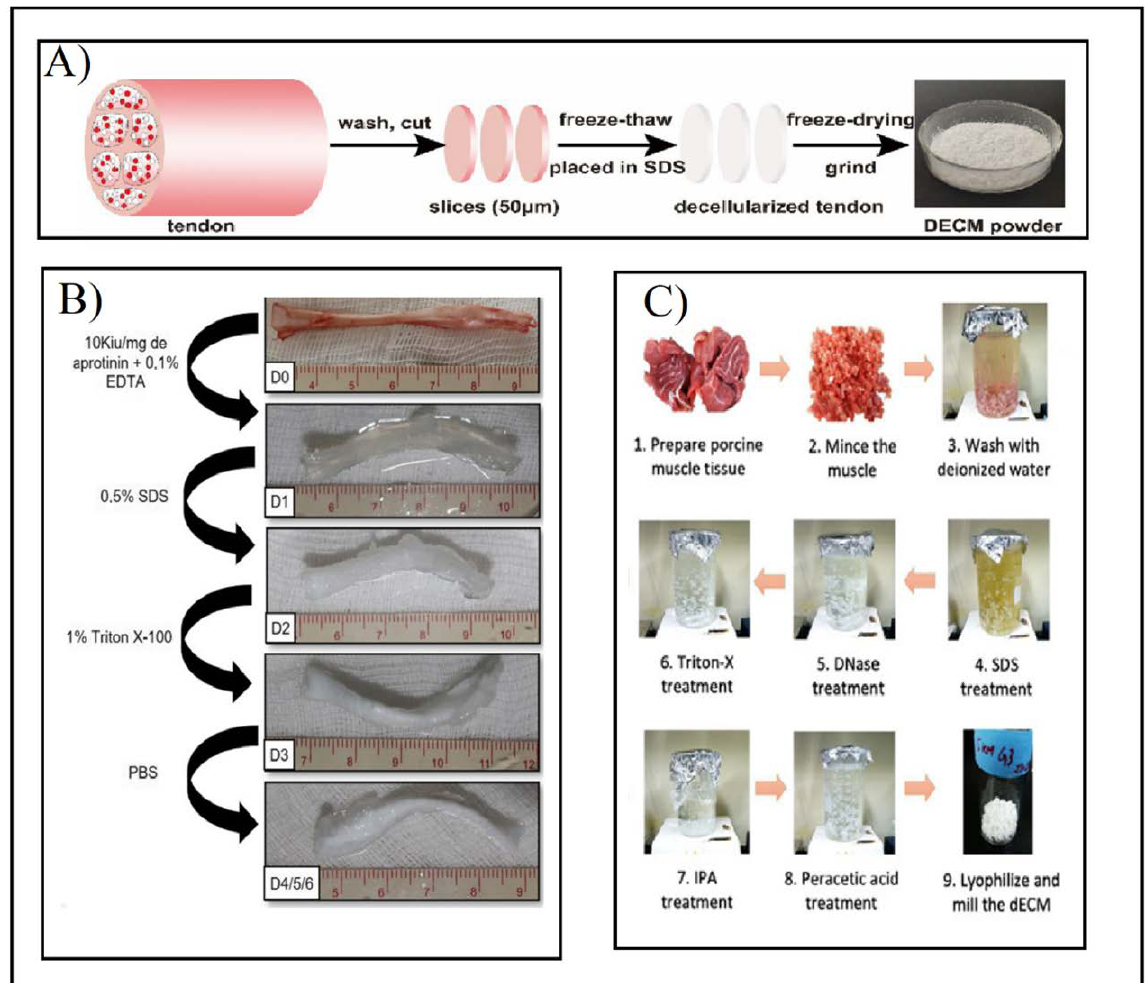
Figure 6. ( A ) Preparation of tendon dECM powder by combining F–T cycles and SDS after washing, cutting, and slicing the tendon. Adapted from [42]. ( B ) Multi-stage tendon decellularization protocol. Aprotinin and EDTA were added to fresh tendons (D0). Then 0.5% SDS (D1) and 1% Triton